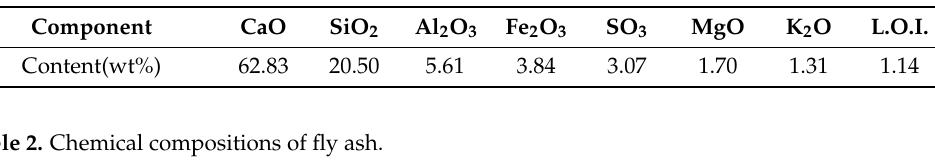
Table 1. Chemical compositions of Ordinary Portland Cement (OPC).